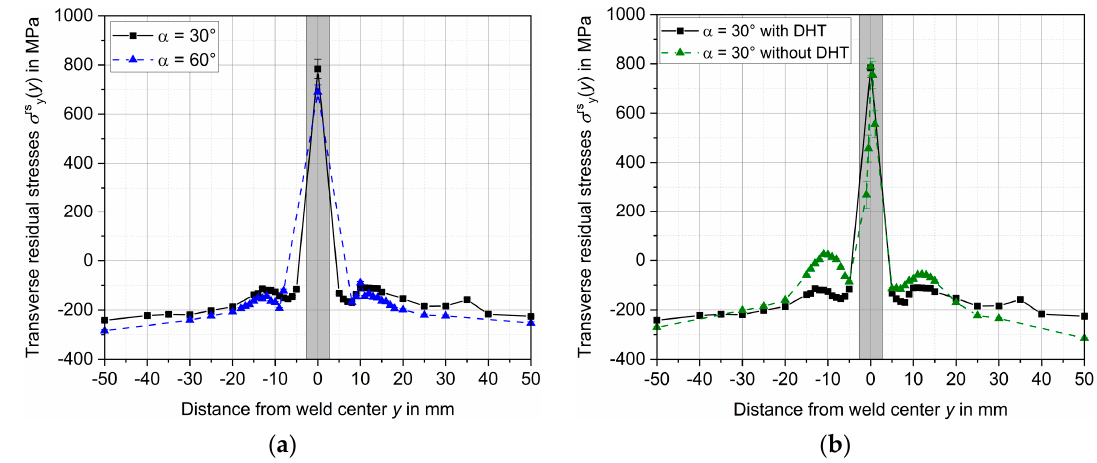
Figure 7. Transverse residual stress distributions σ rsy ( y ) on the surface of welded TEKKEN samples: ( a ) Influence of seam opening angle α ; ( b ) Influence of DHT.